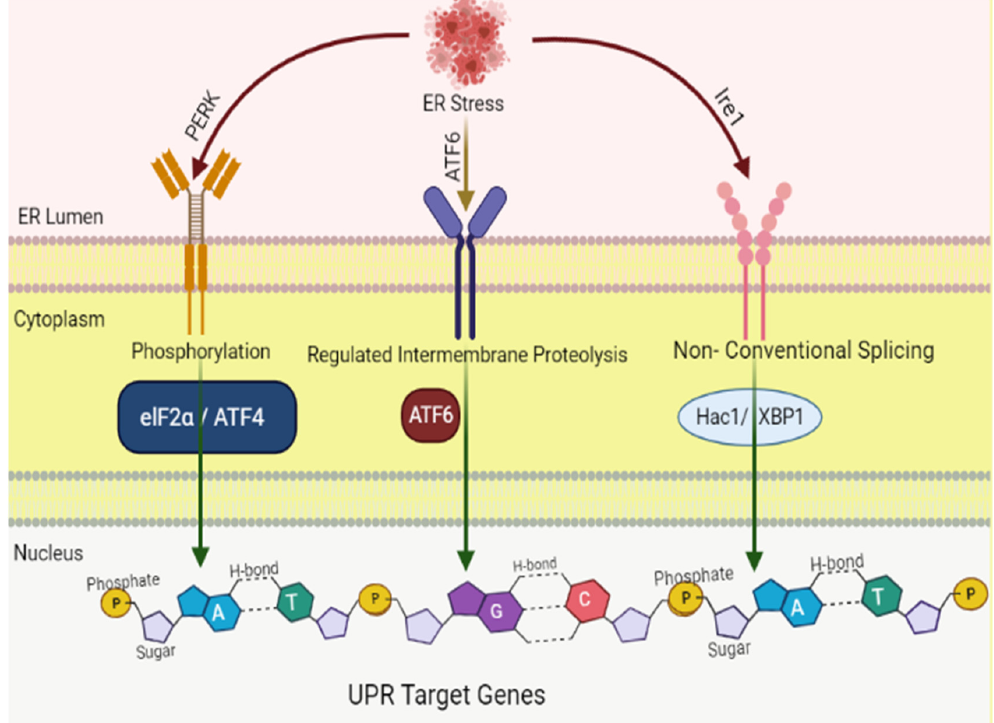
Figure 1. Signaling pathways initiated by the three branches of the unfolded protein response (UPR). Three signaling pathways are involved in the UPR, each of which is controlled by three ER membrane proteins: ATF6 (activating transcription factor 6), IRE-1 (inositol-requiring protein 1; official name: ERN1), and PERK (protein kinase-like ER kinase, pancreatic ER eukaryotic translation initiation factor (eIF)-2a kinase; official name: EIF2AK3). The UPR is a complicated cellular signaling mechanism that tries to reestablish cellular equilibrium. However, in the face of sustained ER stress, pathways that induce apoptosis may be